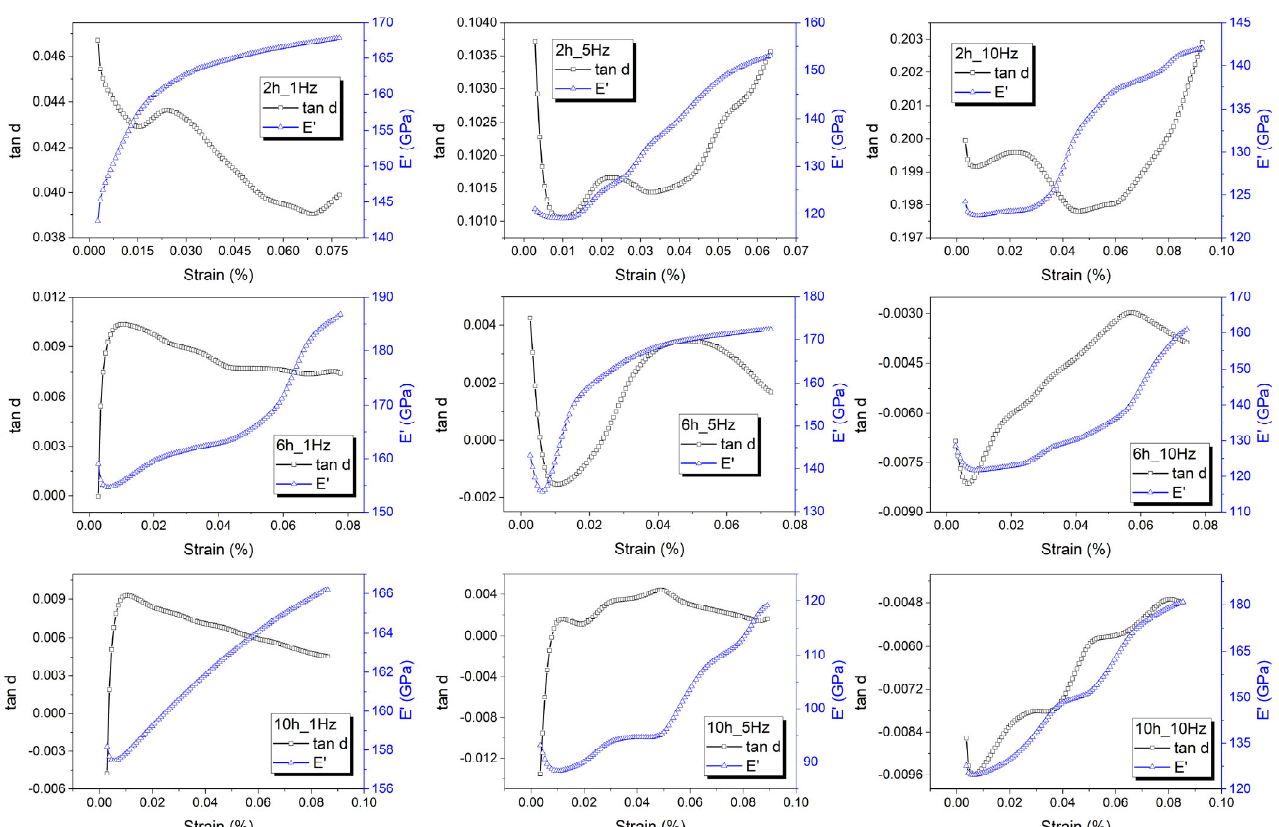
Figure 2. Variations of the average values of E’ and tan δ with strain amplitude as a function of holding time (2, 6, and 10 h, from left to right) and strain sweep frequency (1, 5, and 10 Hz, from top to bo tt om).